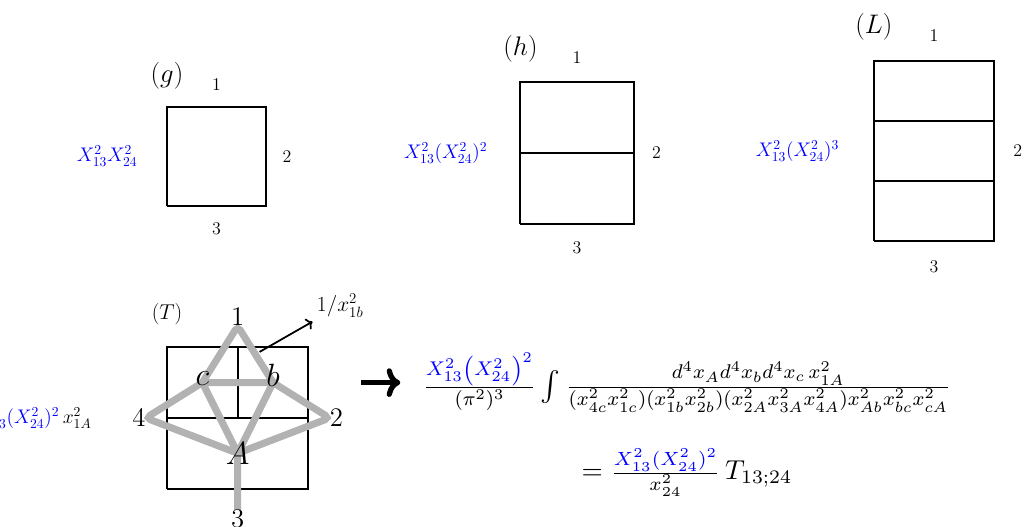
Figure 7 . Conformal integrals in the four-particle amplitude integrand up to 3 loops. The first line shows one-loop, two-loop and three-loop ladder integrals in momentum space representations. The last line illustrates, for the three-loop tennis-court integral, the planar graph duality which relates the momentum and position space